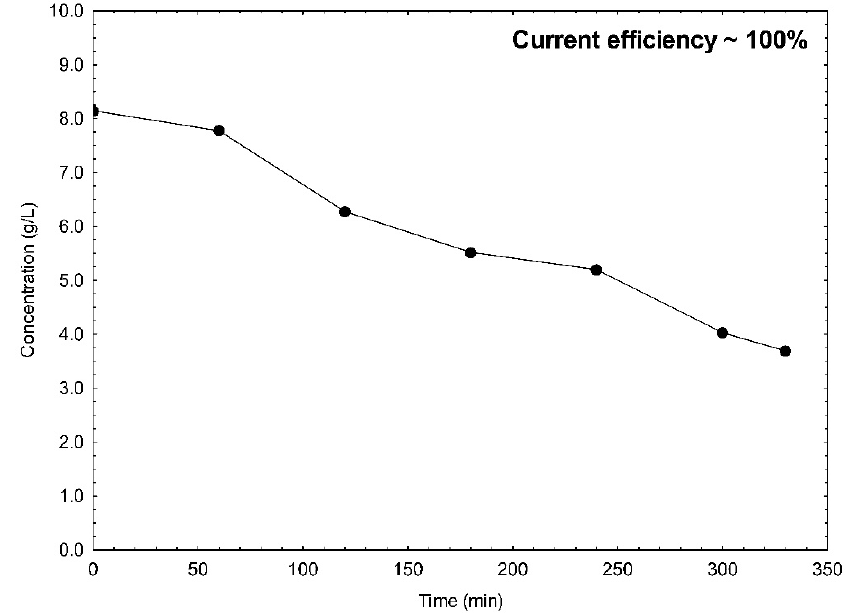
Figure 5. Variation of copper concentration as a function of electrowinning time in the sequential test, presented in Figure 3, at 250 A/m 2 , pH = 4 and room temperature for the CuSO 4 synthetic